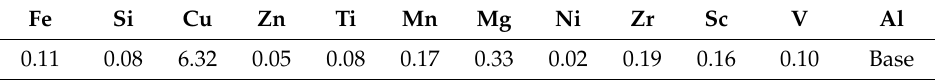
Table 1. Chemical composition of AA2519 extrusion to be welded.